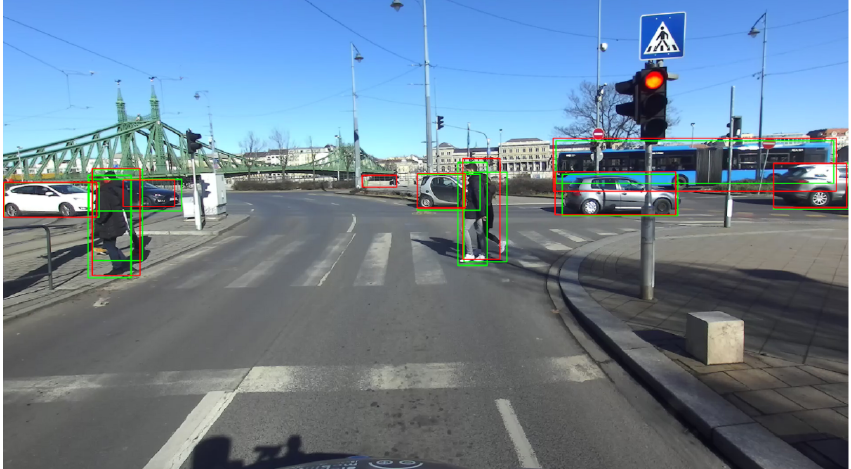
Figure 3. Example image of the output of the ZED 2 object detector generated using the toolkit proposed by Padilla et al. [31]. Bounding boxes of the detections are shown in red. Bounding boxes of the ground truth annotations are shown in